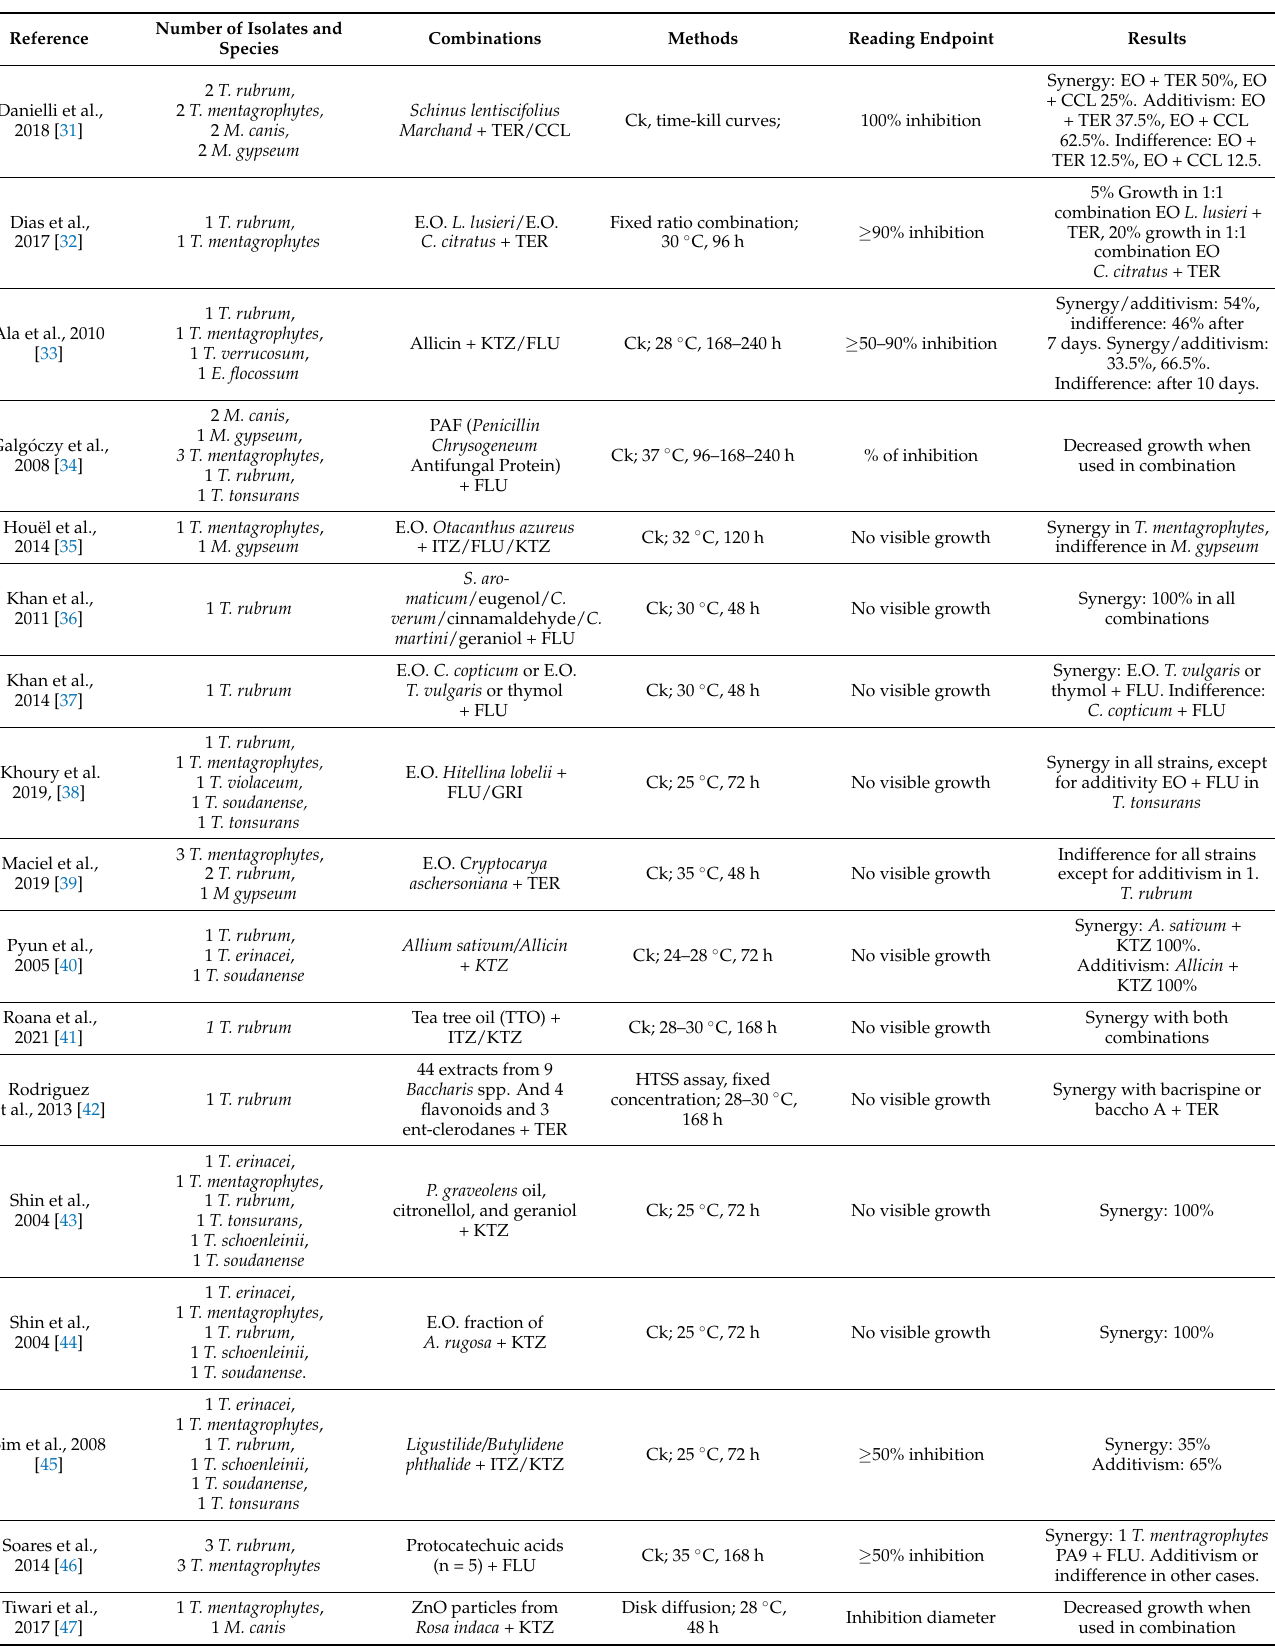
Table 2. Antifungal combinations against dermatophytes: in vitro effects of an antifungal plus a chemical compound other than